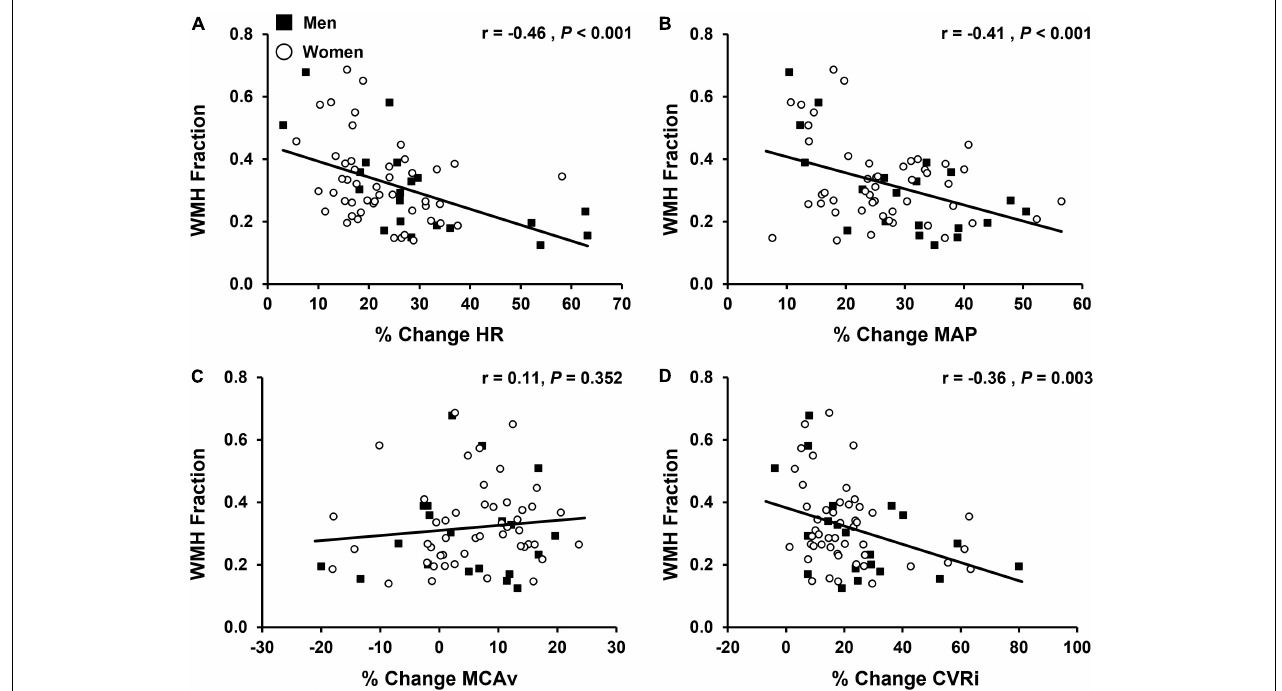
FIGURE 4 | Associations between the percent change (% change) from baseline values in cardiovascular and cerebrovascular variables during the final tertile of isometric handgrip exercise (EX T3) and white matter hyperintensity (WMH) fraction (n = 68). WMH fraction was calculated by dividing WMH lesion volume by intracranial volume, converting to a percentage, and applying a cubic root transformation to reduce skewness. Men are shown in black squares and women are shown in open circles. (A) % change in heart rate, HR vs. WMH; (B) % change in mean arterial pressure, MAP vs. WMH; (C) % change in middle cerebral artery blood velocity, MCAv vs. WMH; (D) % change incerebrovascular resistance index, CVRi vs. WMH. Note: data and statistics shown in figure have not been adjusted for age at MRI, sex, APOE 4 status, or work performed during isometric handgrip exercise. After adjustment for confounding variables, there was a negative association between the % change in HR ( P = 0.002), MAP ( P = 0.002), and CVRi ( P = 0.045) during the final tertile of isometric handgrip exercise and WMH fraction. Corresponding results from multiple linear regression analyses are presented in Tables 4 , 5 .